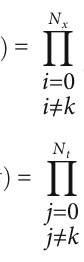
Figure 5: Temperature pro fi le for di ff erent values of He when De = 0 : 1, N = 0 : 5, n = 0 : 5, f δ = NR = 0 : 2, Sc = 0 : 6, and Pr = 1